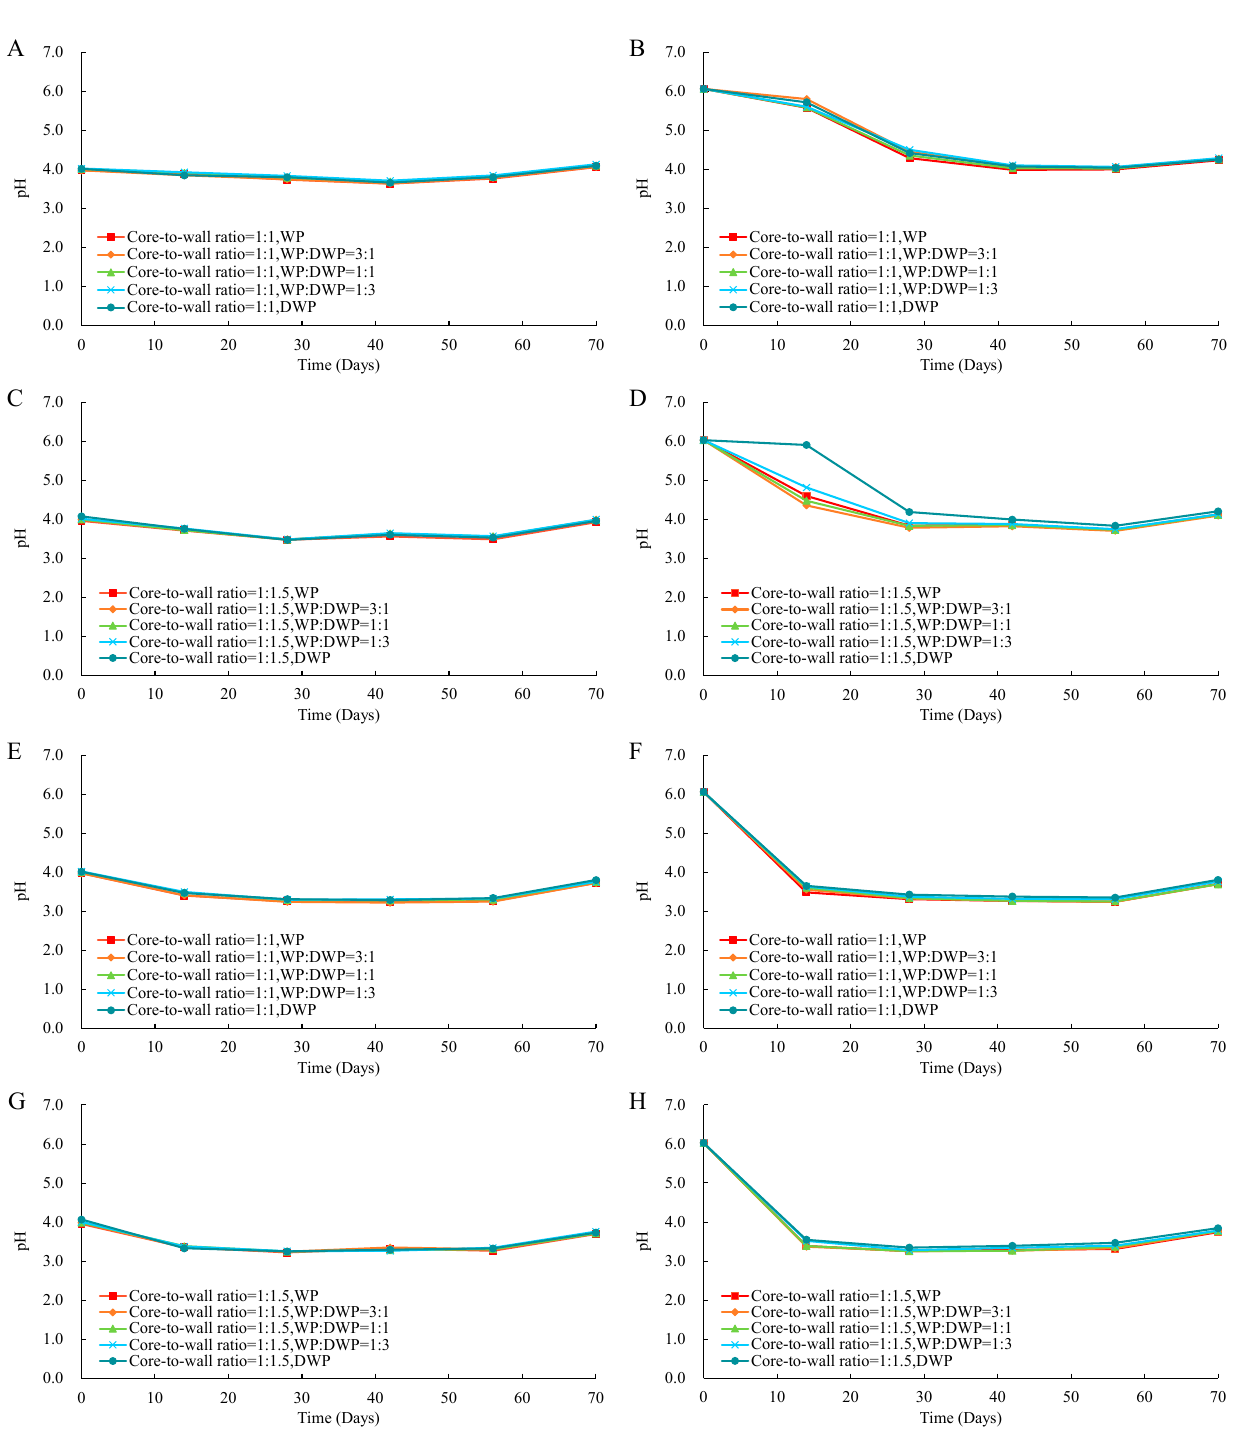
Figure 9. pH of fermented and fortified apple juices. ( A ): 4 °C, fermentation, core ‐ to ‐ wall ratio 1:1; ( B ): 4 °C, fortification, core ‐ to ‐ wall ratio 1:1; ( C ): 4 °C, fermentation, core ‐ to ‐ wall ratio 1:1.5; ( D ): 4 °C, fortification, core ‐ to ‐ wall ratio 1:1.5. ( E ): 25 °C, fermentation, core ‐ to ‐ wall ratio 1:1; ( F ): 25 °C, fortification, core ‐ to ‐ wall ratio 1:1; ( G ): 25 °C, fermentation, core ‐ to ‐ wall ratio 1:1.5; ( H ): 25 °C, fortification, core ‐ to ‐ wall ratio 1:1.5. WP: whey protein, DWP: denatured whey protein.